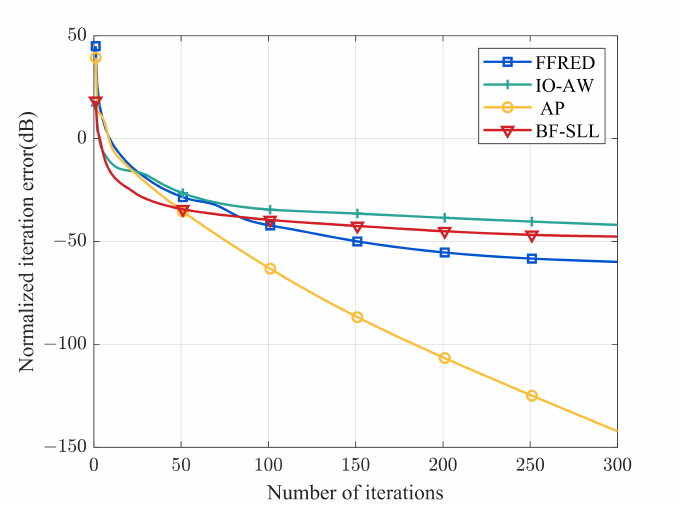
Figure 9. Convergence comparison of different methods by normalized waveform error.